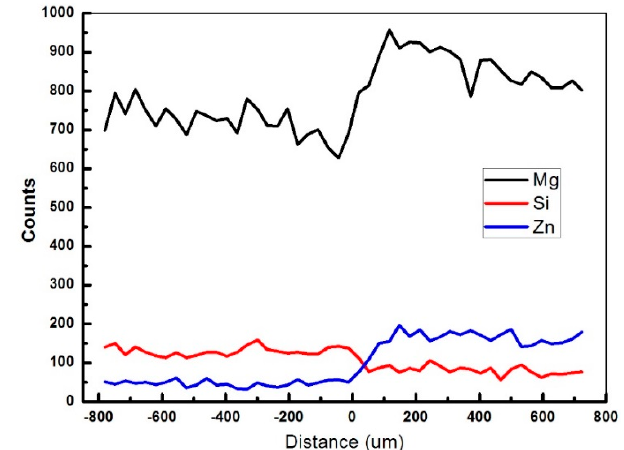
Figure 6. The line profiles of the main alloying elements (Zn, Mg, and Si) obtained along the yellow line in Figure 5a.